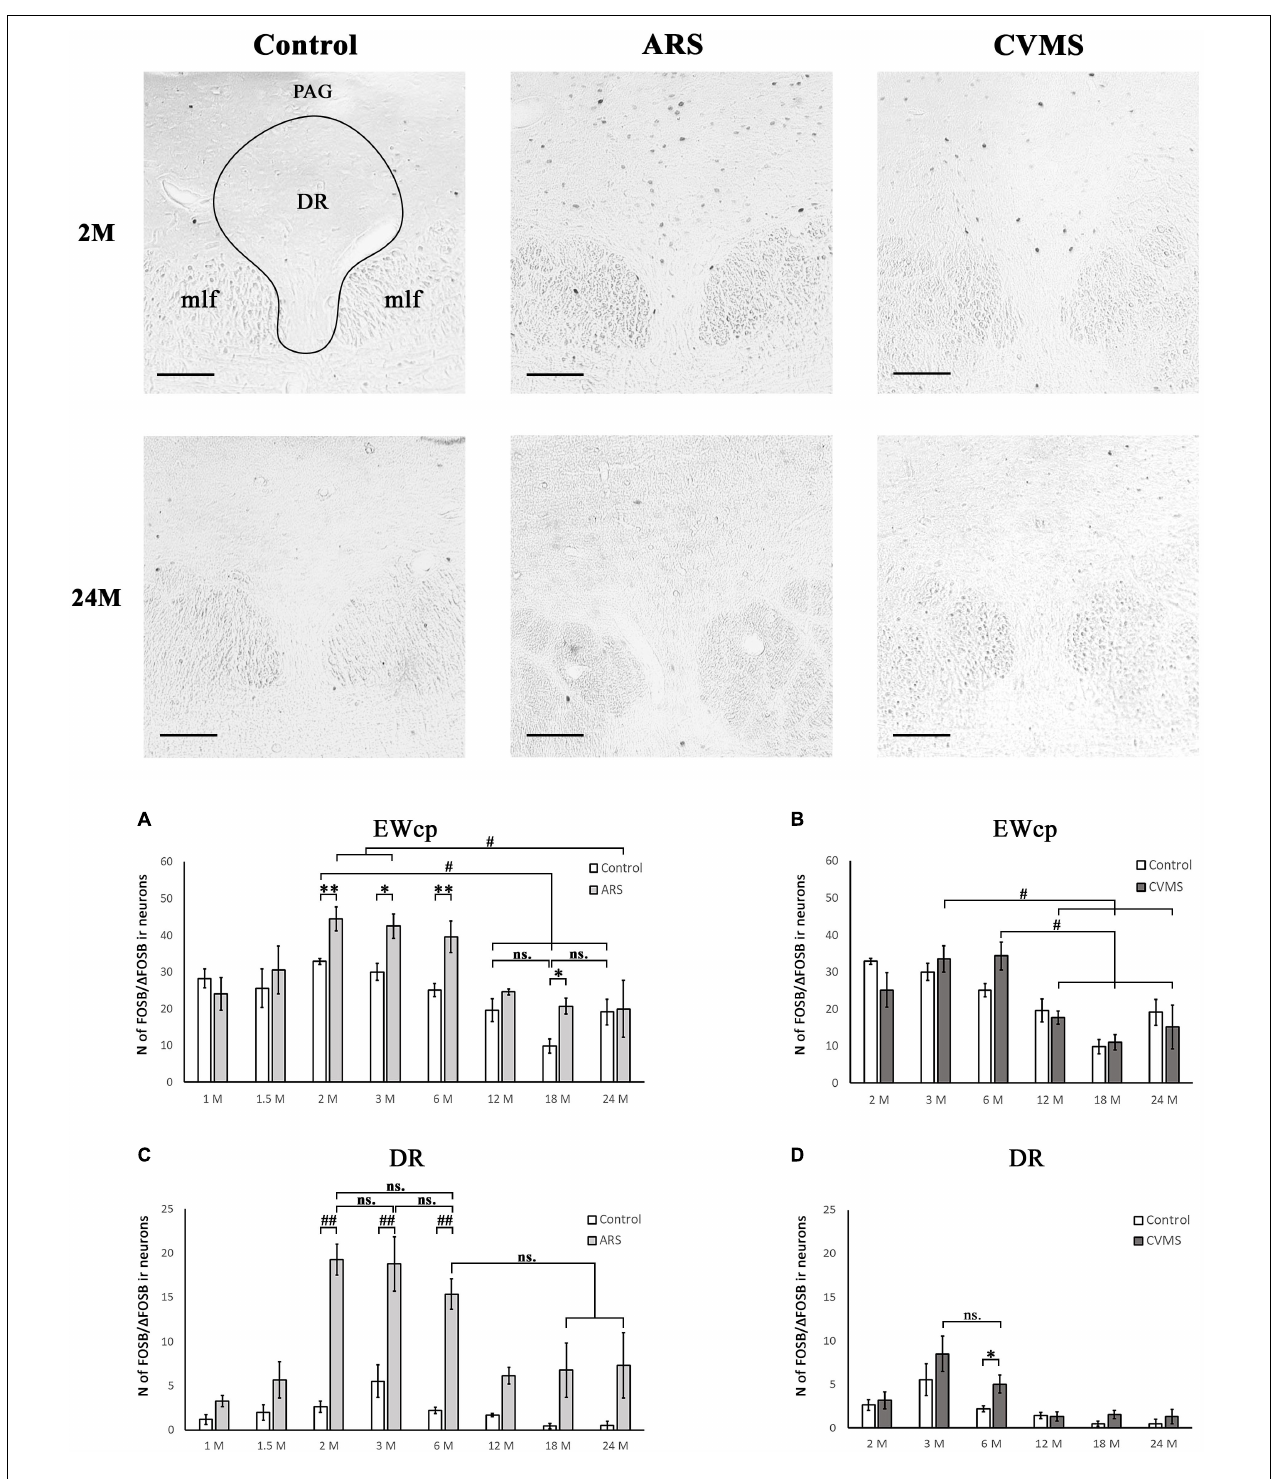
FIGURE 7 | Age-dependent FOSB/ (cid:49) FOSB immunoreactivity (IR) in dorsal raphe (DR) and the centrally-projecting Edinger-Westphal (EWcp) nuclei. Representative images of DR in 2- and 24-month-old (M) control, acute restraint stress (ARS)- and chronic variable mild stress (CVMS)-exposed rats at –7.80 mm to the Bregma. The number of FOSB/ (cid:49) FOSB IR nuclei was compared among eight age groups in histogram (A,B) for DR and (C,D) for the EWcp. Open bars represent the control groups; light gray columns refer to ARS-exposed rats; the dark gray columns indicate the CVMS-exposed animals ( N = 4–7). # p < 0.05, ## p < 0.01 (ns, not significant) according to Tukey’s post-hoc test. ∗ p < 0.05, ∗∗ p < 0.01 according to t -tests. mlf, medial longitudinal fasciculus; PAG, periaqueductal gray Scale bar: 100 µ m.